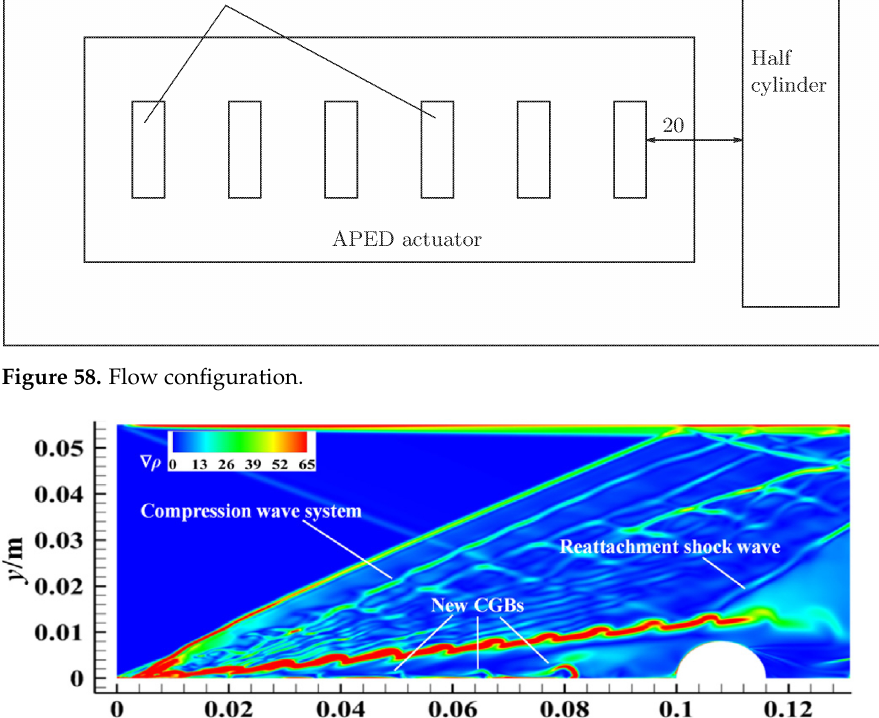
Figure 59. Instantaneous density contours for ω = 1.55. Reprint from [110] with the permission of AIP